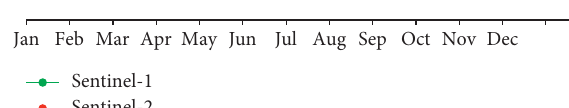
Table 1: Mathematical formulas for calculating texture features using GLCM statistics: the mean, variance, and correlation. Texture